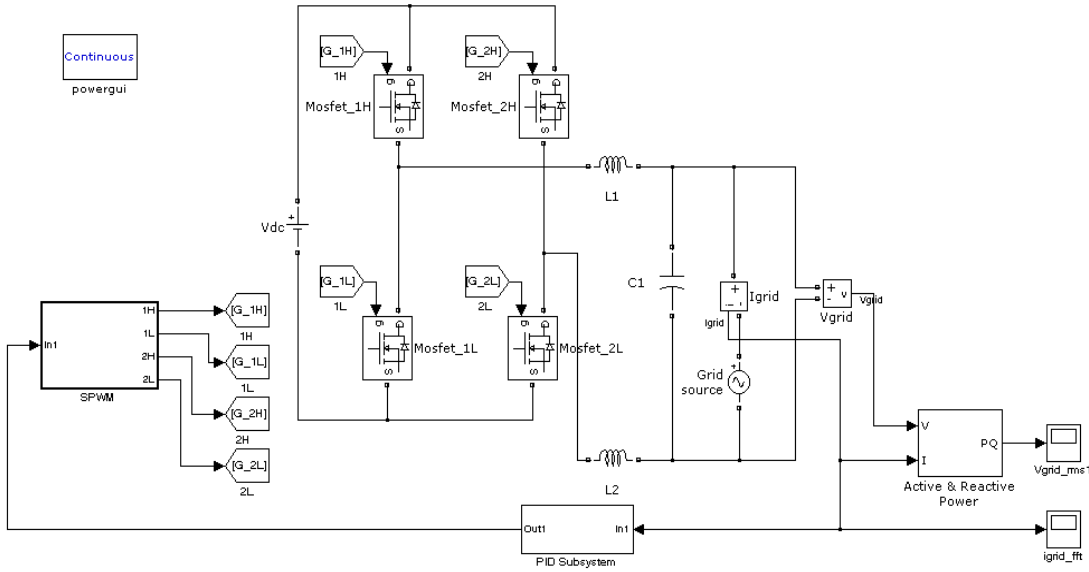
Figure 3. Simulink diagram representing a single-phase full-bridge vehicle-to-grid connected system.